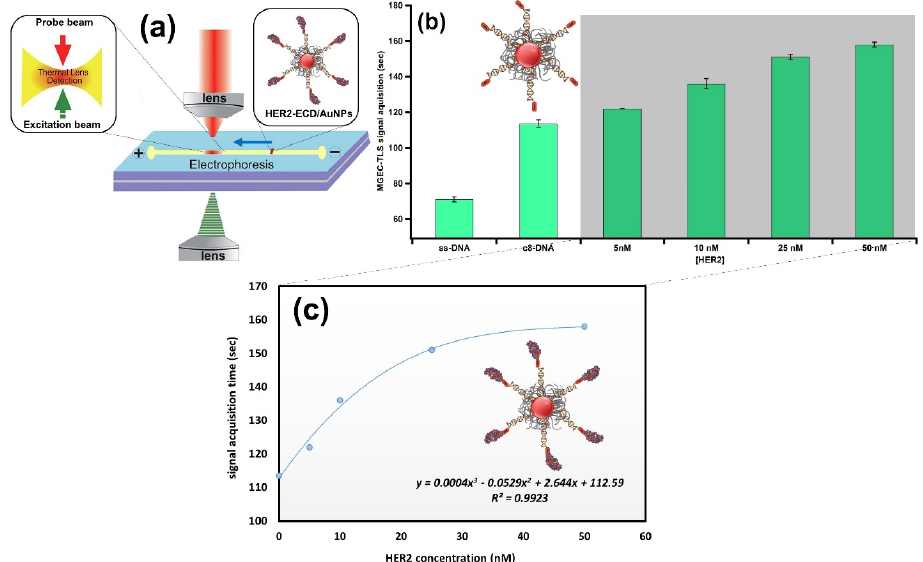
Figure 8. ( a ) A schematic illustration of the MGEC-TLS design employed for investigating HER2- ECD binding to C8-decorated AuNPs. The resulting immunoconjugates migrate toward the positive anode crossing the measurement point. ( b ) The MGEC-TLS signal acquisition time as a function of different steps of surface coating of AuNPs. The concentration of the antigen was varied from 5- 50 nM. ( c ) Signal acquisition time curve of HER2-ECD measured with MGEC-TLS. The signal acquisition time is plotted versus HER2-ECD concentration; experimental data were fitted with a polynomial of third degree.